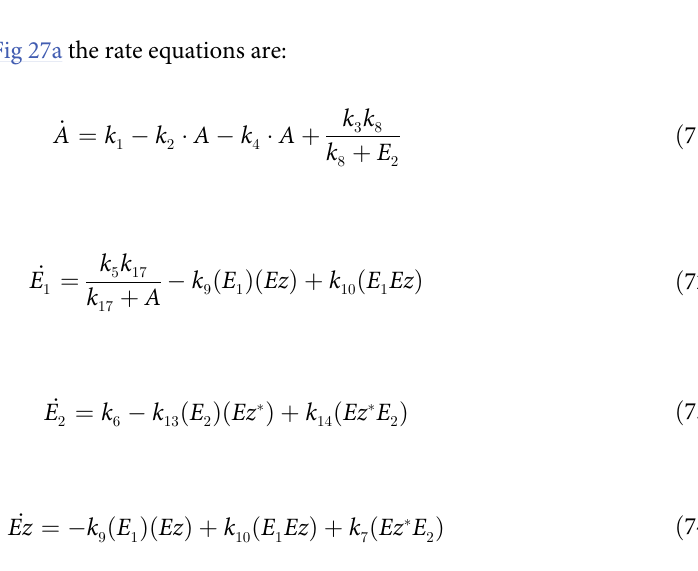
Fig 27. Reaction schemes when E 1 and E 2 in a m4-type of control structure (Fig 3) are removed by enzyme Ez following two ping-pong mechanisms. In (a) E 1 binds first to the free enzyme Ez , while in (b) E 2 binds first.